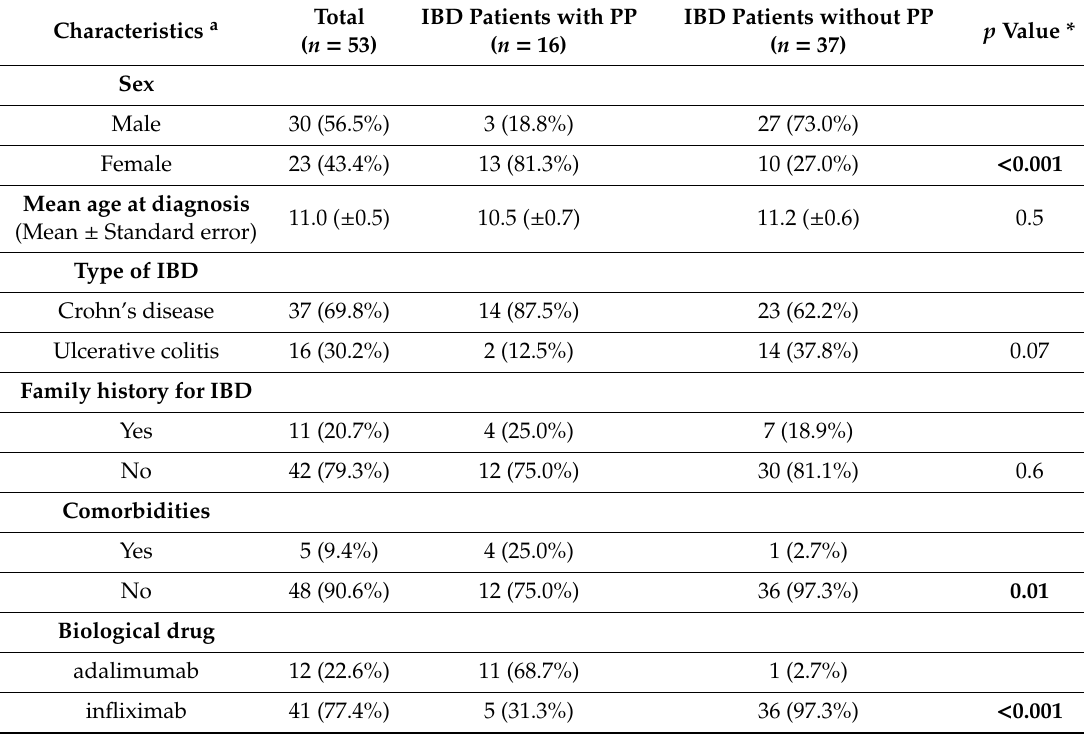
Table 1. Clinical–pathologic characteristics of inflammatory bowel diseases (IBD) patients with and without paradoxical psoriasis